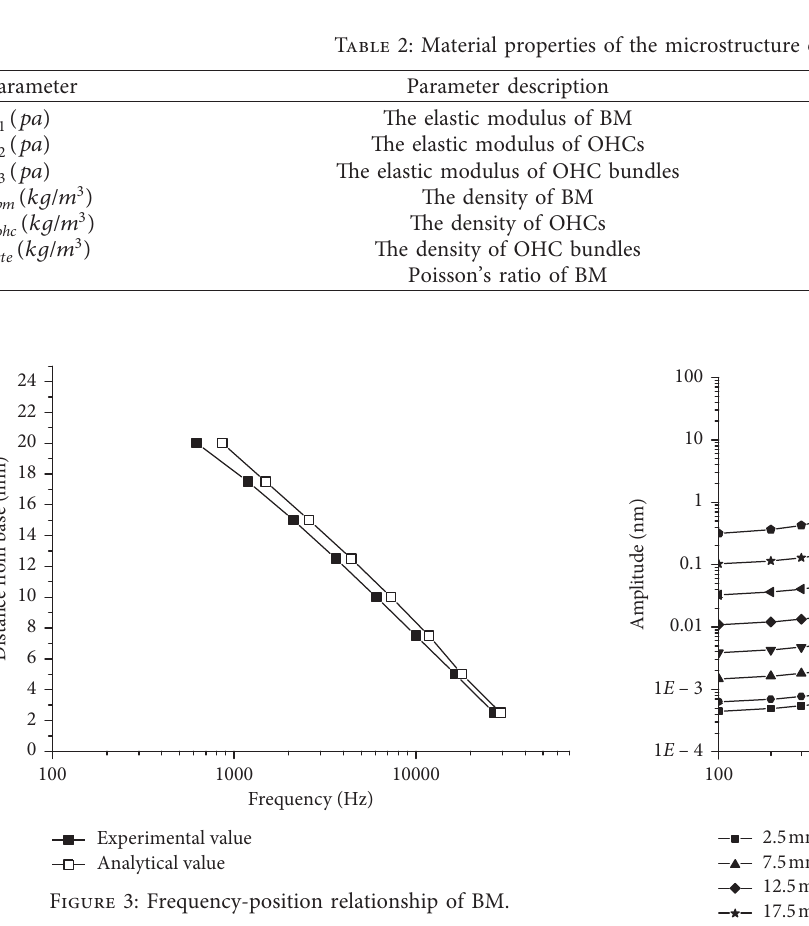
Figure 4: Frequency response graph of corresponding